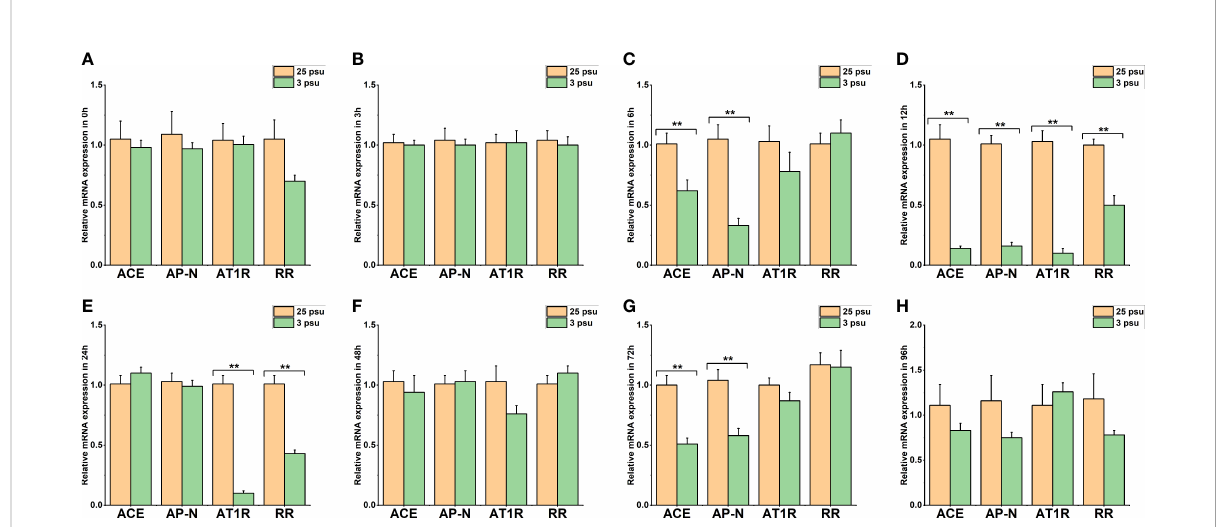
FIGURE 7 The expression levels of LV-ACE , LV-APN , LV-AT 1 R , and LV-RR in the eyestalk at 0 h (A) , 3 h (B) , 6 h (C) , 12 h (D) , 24 h (E) , 48 h (F) , 72 h (G) , and 96 h (H) of short-term low salinity stress. Signi fi cant differences are indicated with ** marks ( P < 0.05). Values are the mean ( ± SD). (N = 6).